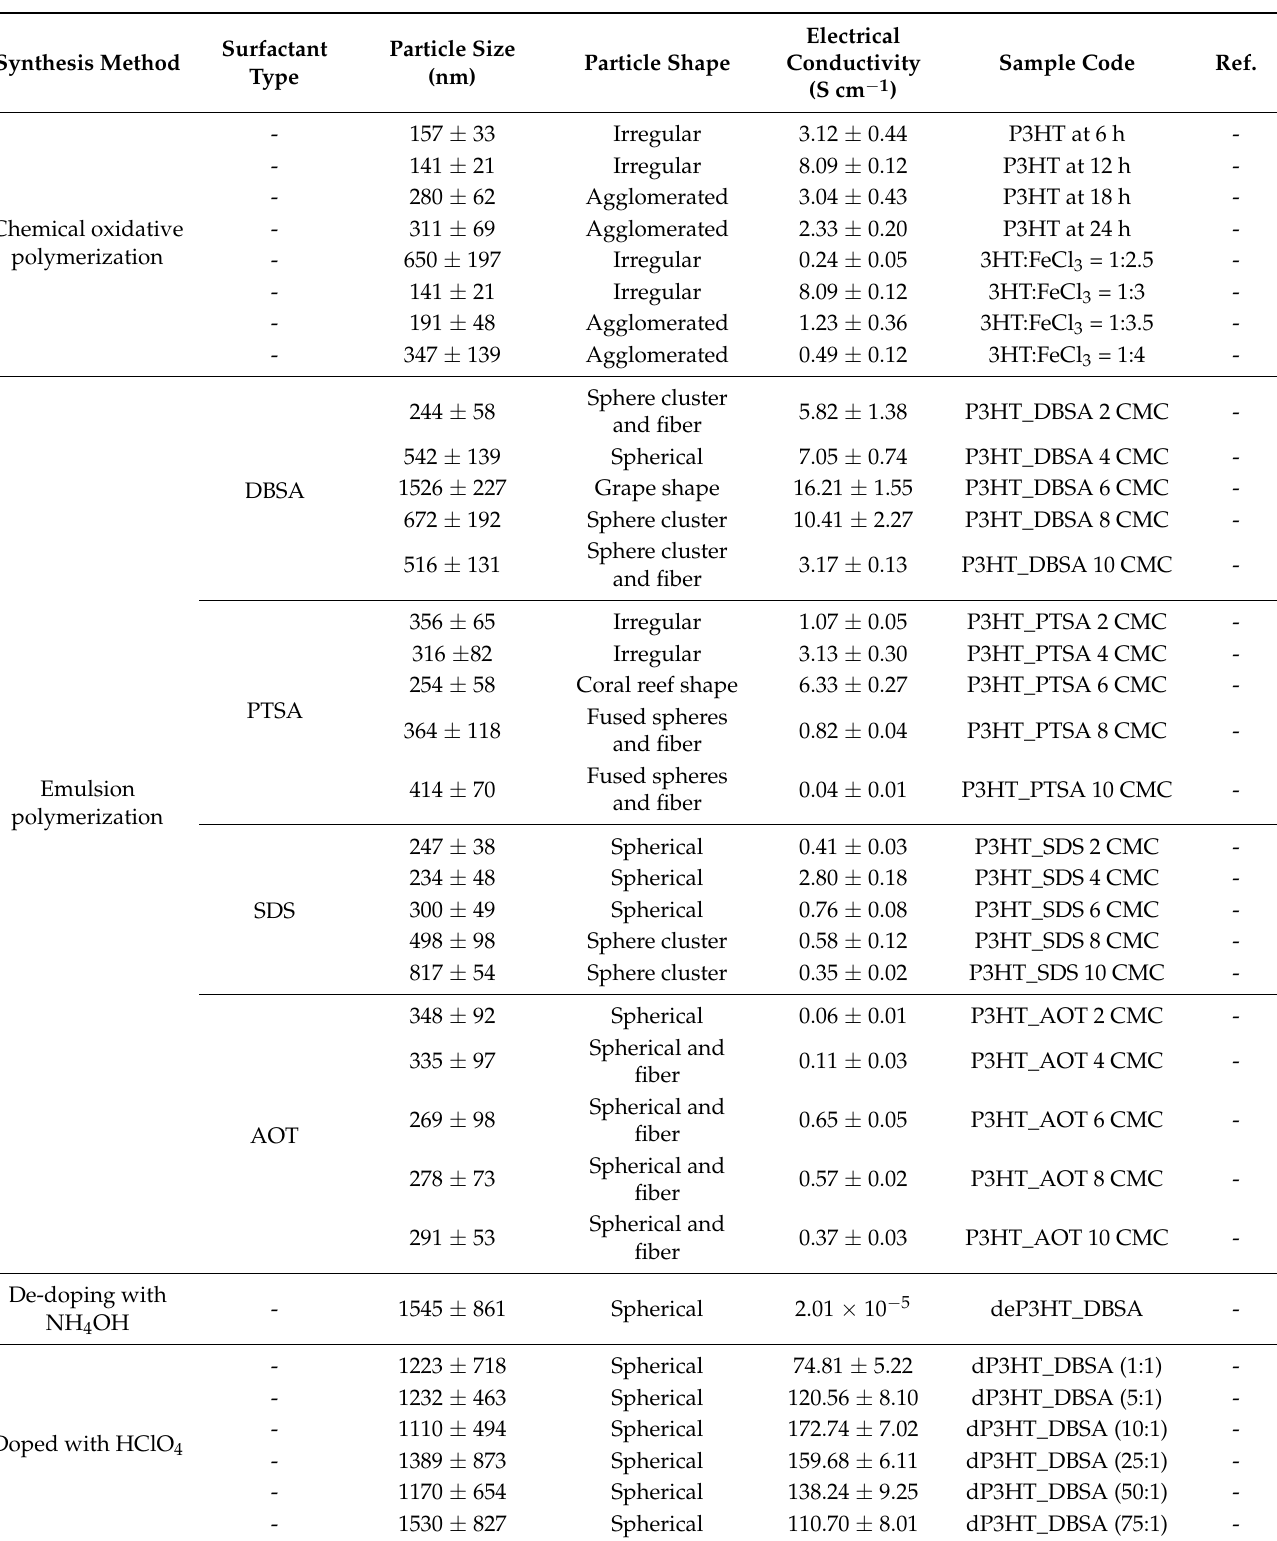
Table 1. Comparison of particle size, particle shape, and electrical conductivity of P3HT with previous